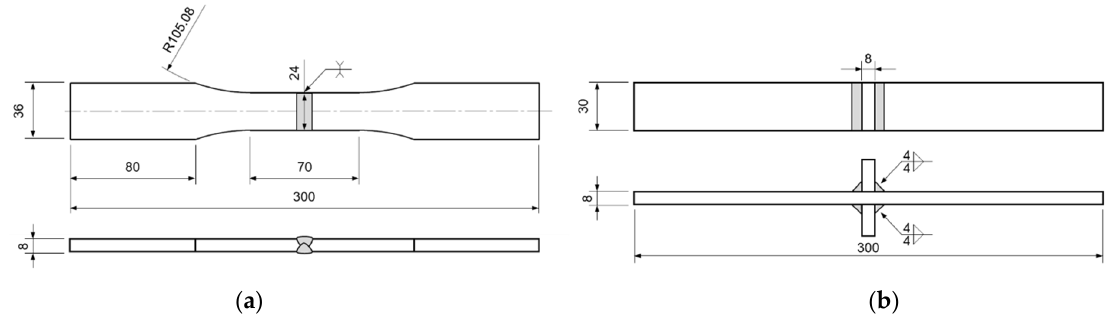
Figure 2. Specimen geometry and welding symbols acc. to ISO 2553 [27] ( a ) Butt joint specimen; ( b ) Specimen with transverse stiffeners.